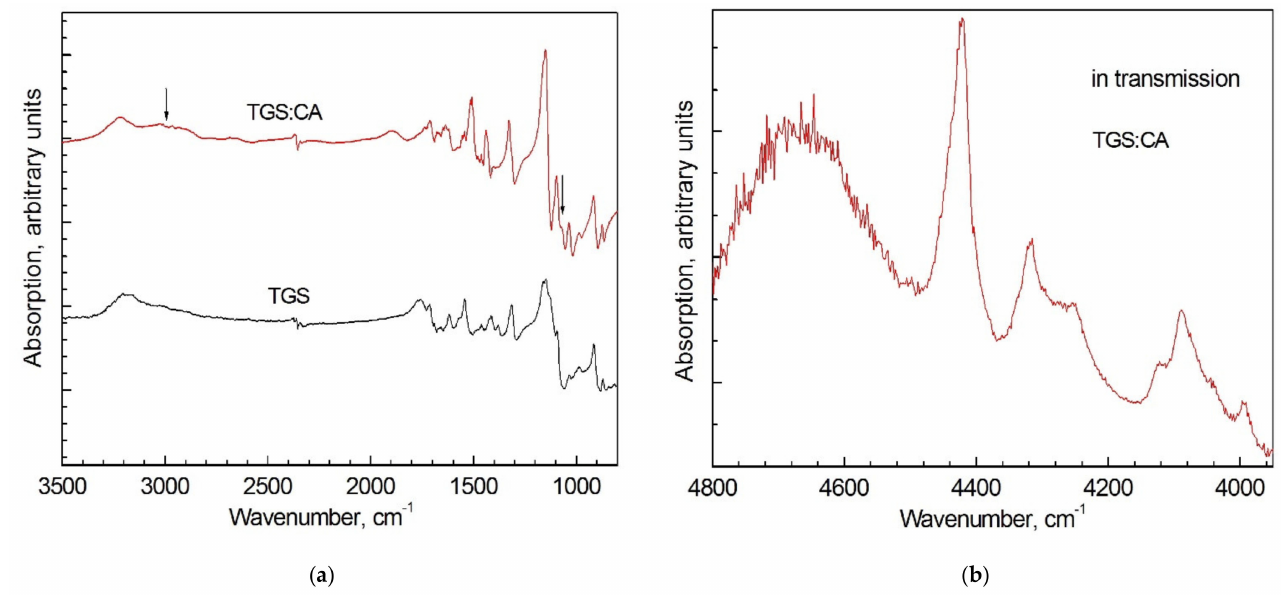
Figure 6. FTIR absorption spectra in ( a ) TGS:CA (90:10) and TGS crystals in spectral range ν = 800–3500 cm − 1 and ( b ) TGS:CA (90:10) for ν = 4000–4800 cm − 1 . Arrows in ( a ) indicate the absorption regions caused by CA molecules. For better visualization, the spectra in ( a ) are shifted along vertical